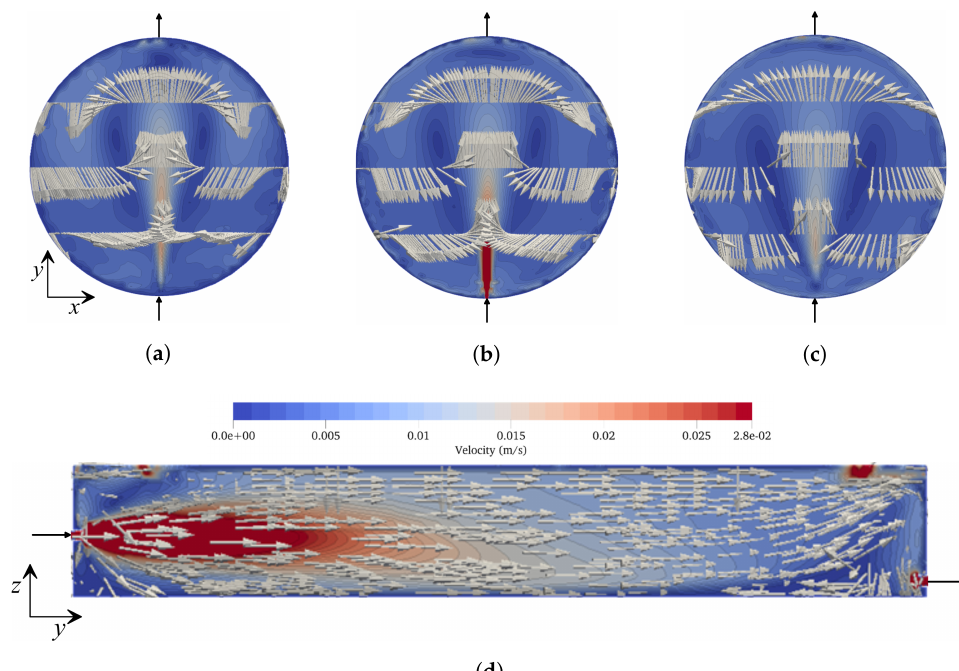
Figure 10. Plunging jet: velocity vectors and contours at 200 s in the horizontal plane at ( a ) z = 0.25 H ; ( b ) z = 0.5 H ; ( c ) z = 0.75 H ; and in the vertical plane at ( d ) y = 0.5 D T